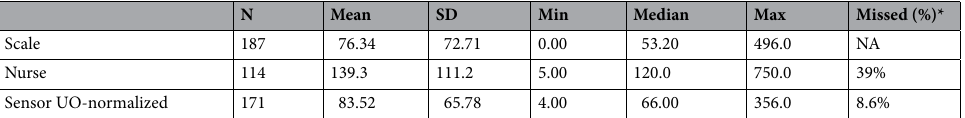
Table 1. Hourly urine output assessed by three methods. N indicates the number of patient-hours included. SD, standard deviation. NA is not applicable. *Percent of hours where no value was